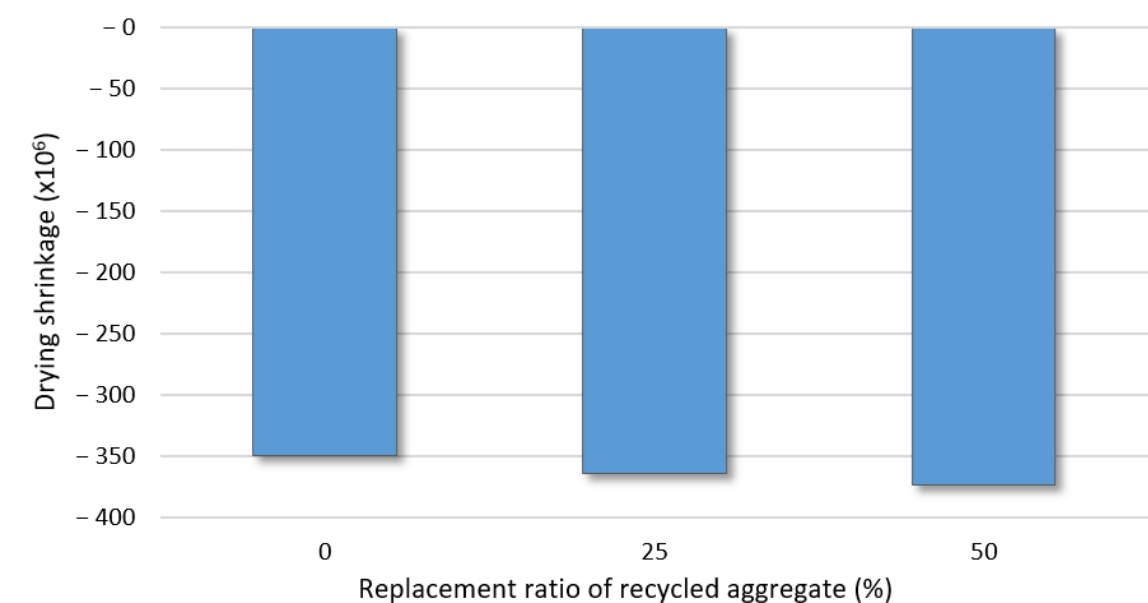
Figure 11. Drying shrinkage of concrete specimens according to replacement ratio of recycled aggregate.